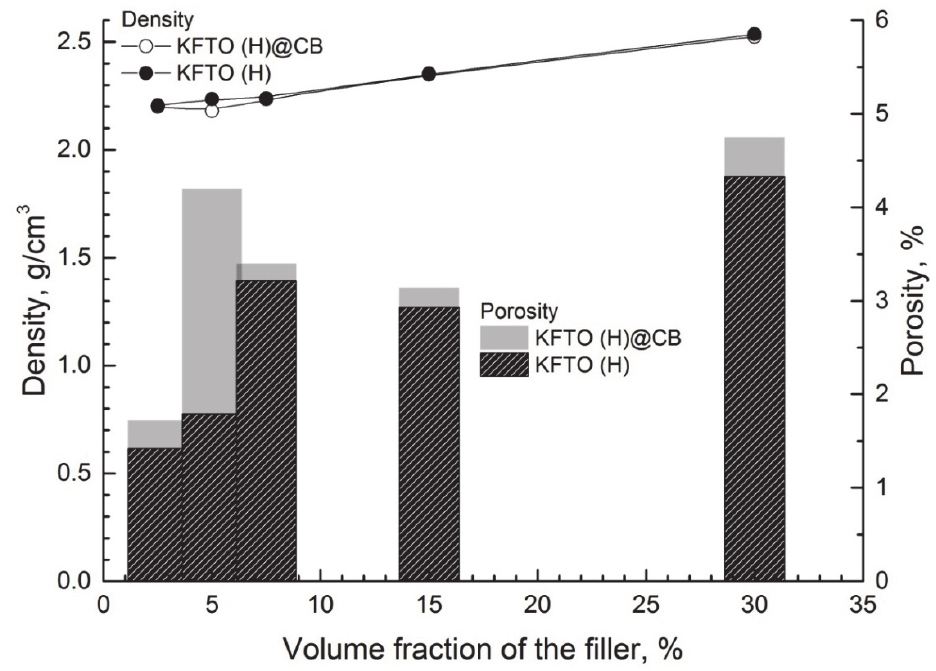
Figure 6. Porosity diagram of PTFE/KFTO(H)@CB and PTFE/KFTO(H) composites as a function of filler volume fraction.